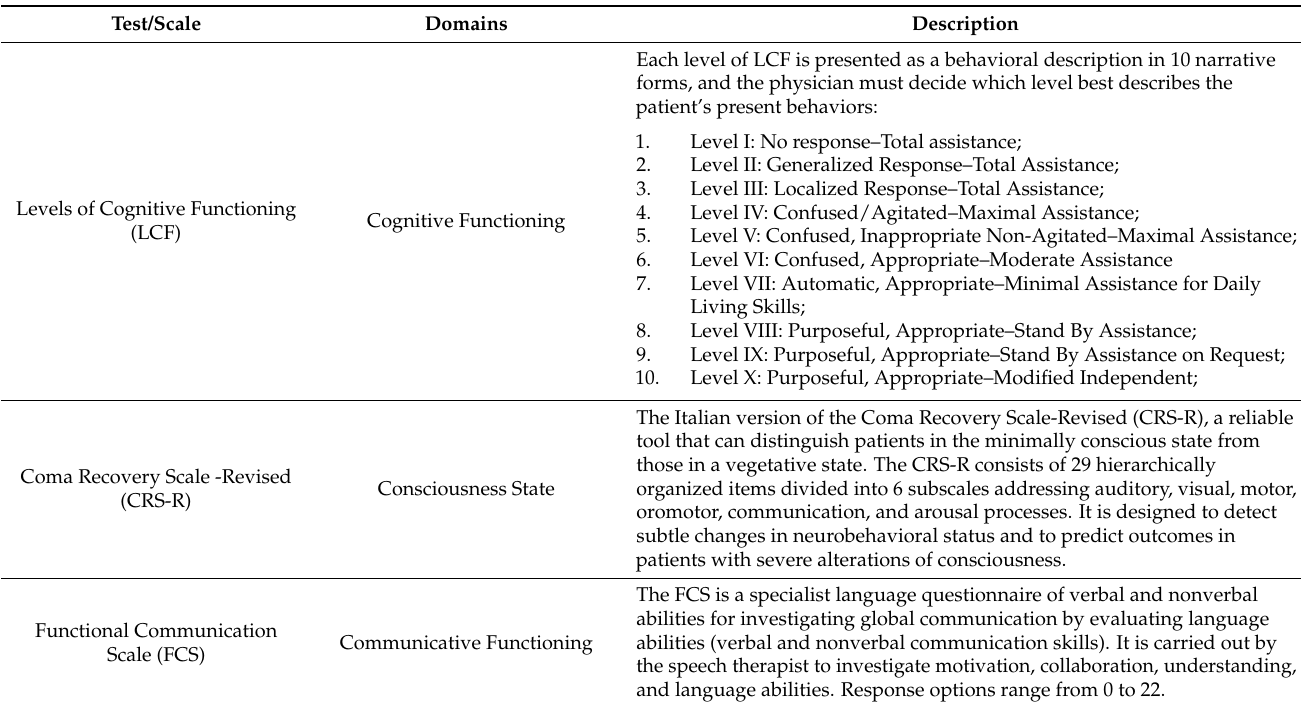
Table 2. Motor-cognitive assessments for patients with